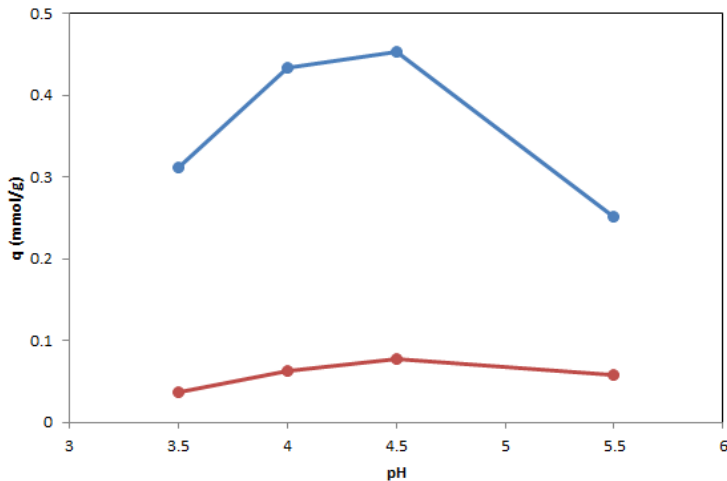
Fig. 10. Diagram of equilibrium uranium ion adsorption as a function of Fig. 10 .